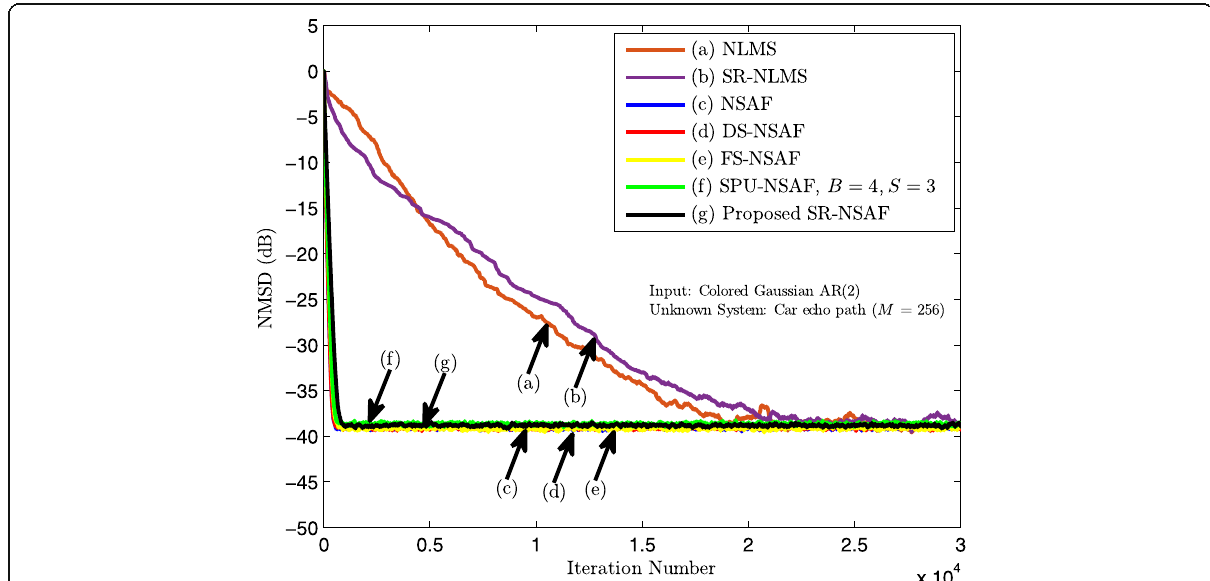
Fig. 8 NMSD learning curves of NLMS, SR-NLMS, NSAF, DS-NSAF, FS-NSAF, SPU-NSAF, and SR-NSAF with N = 8